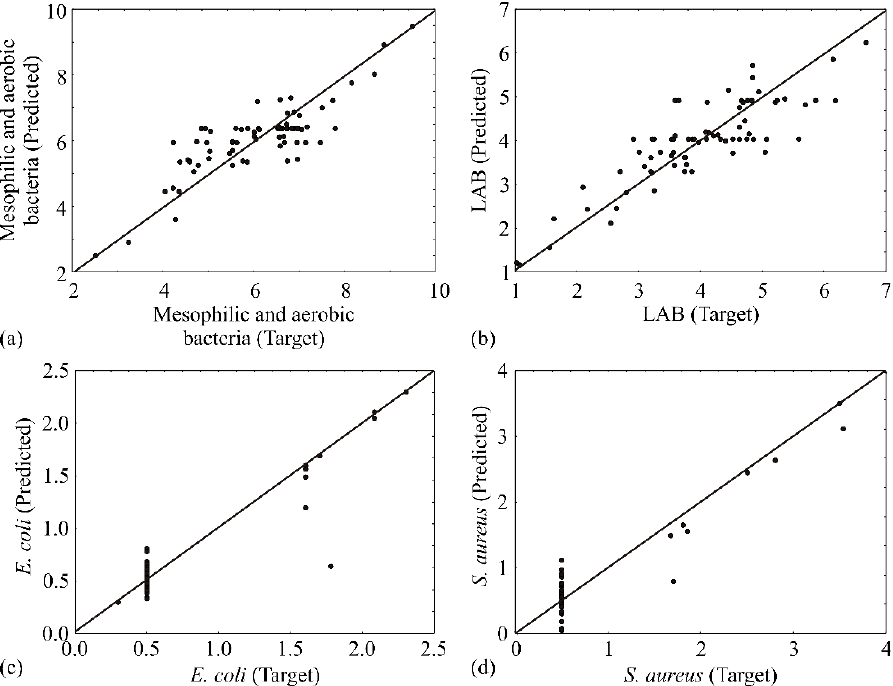
Figure 3. Experimentally gained and the ANN predicted values of the microbiological profile of minced meat: ( a ) Mesophilic and aerobic bacteria, ( b ) LAB. ( c ) E. coli , ( d ) S. aureus Table 4. Coefficients assigned to the hidden and the output layers (weights and